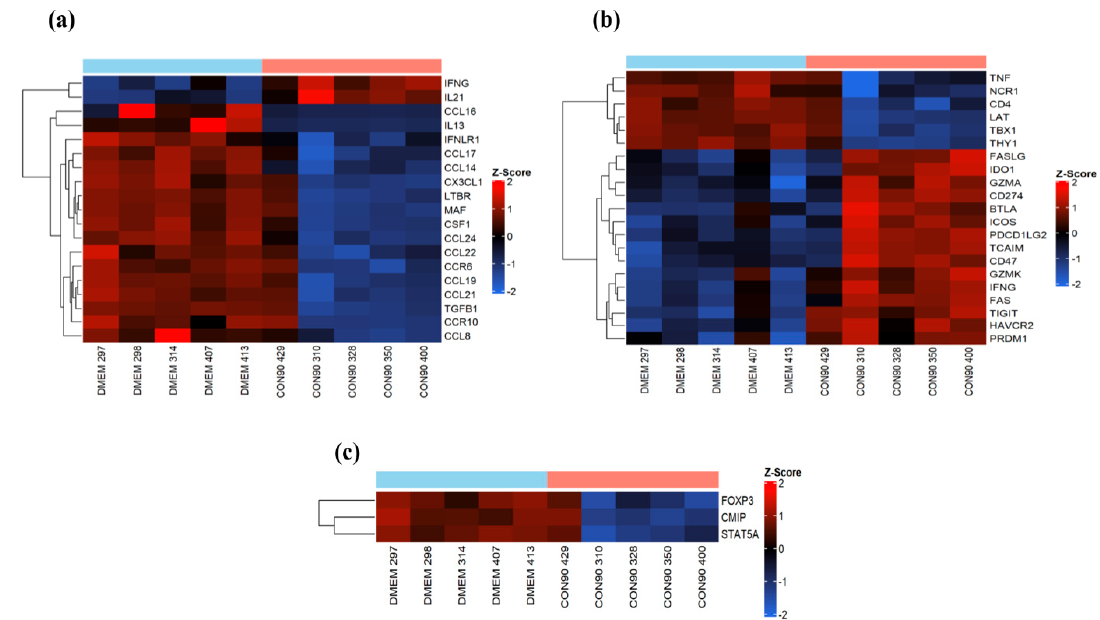
Figure 6. Analysis of cell-mediated immune responses in persistently infected animals. ( a ) Heatmap showing the expression of known cytokines and chemokines and receptors which showed a significant change; ( b ) heatmap showing the genes associated with T-cell development and effector functions; ( c ) heatmap showing the genes involved in T cell-mediated regulatory responses. These heatmaps were generated in the same manner as described in the legend to Figure 4.